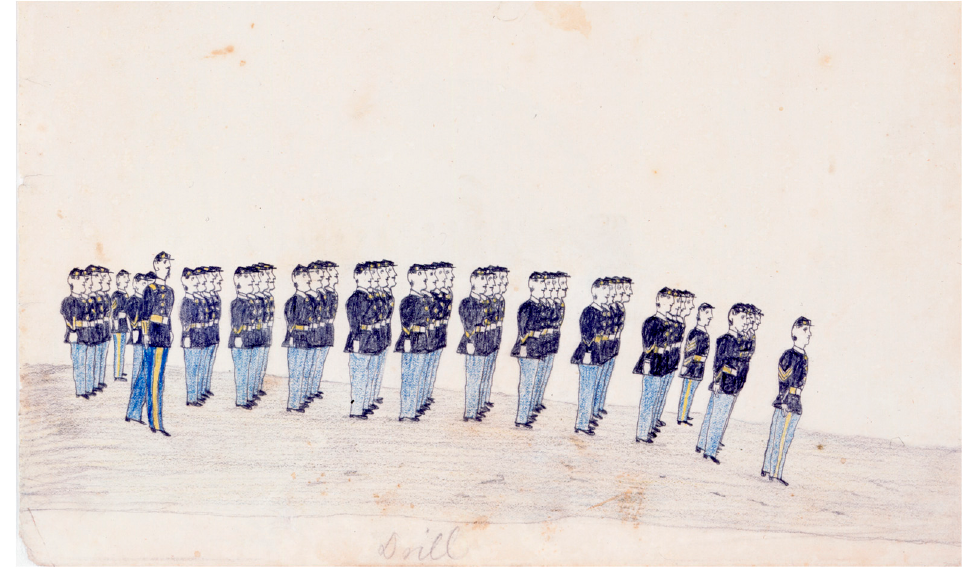
Figure 7. Zó̱ tâm (Driftwood) depicts his fellow Native prisoners performing drills in military uniforms. Credit: Dickinson Research Center, National Cowboy and Western Heritage Museum, Oklahoma City, Oklahoma.